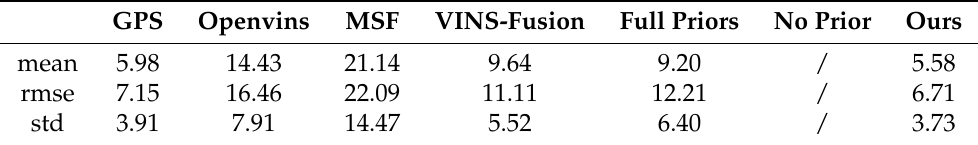
Table 3. ATE error (m) tested on KAIST